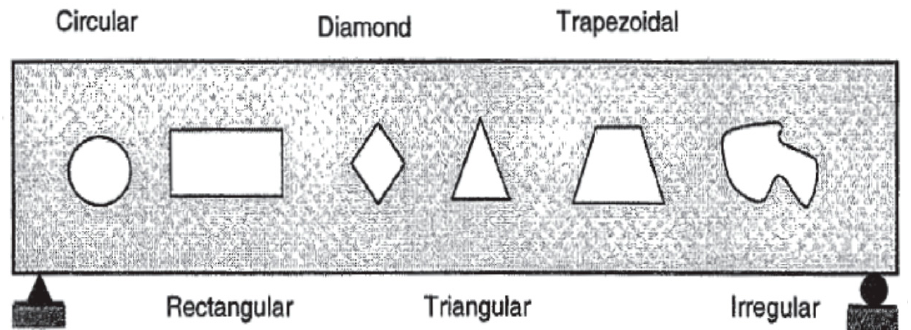
Figure 2. Different forms of opening shapes [32]. Figure 2. Di ff erent forms of opening shapes